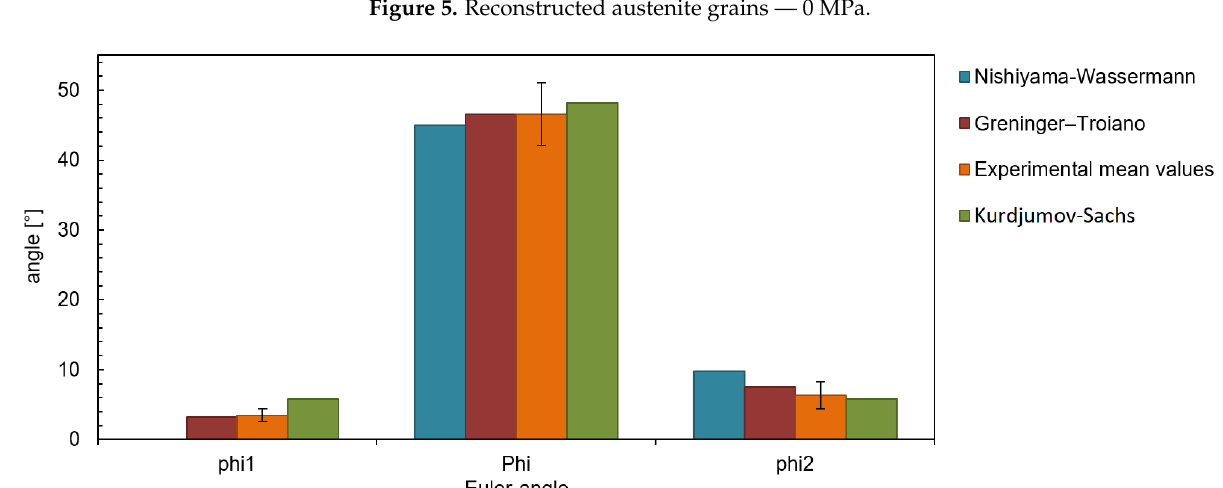
Figure 5. Reconstructed austenite grains — 0 MPa.